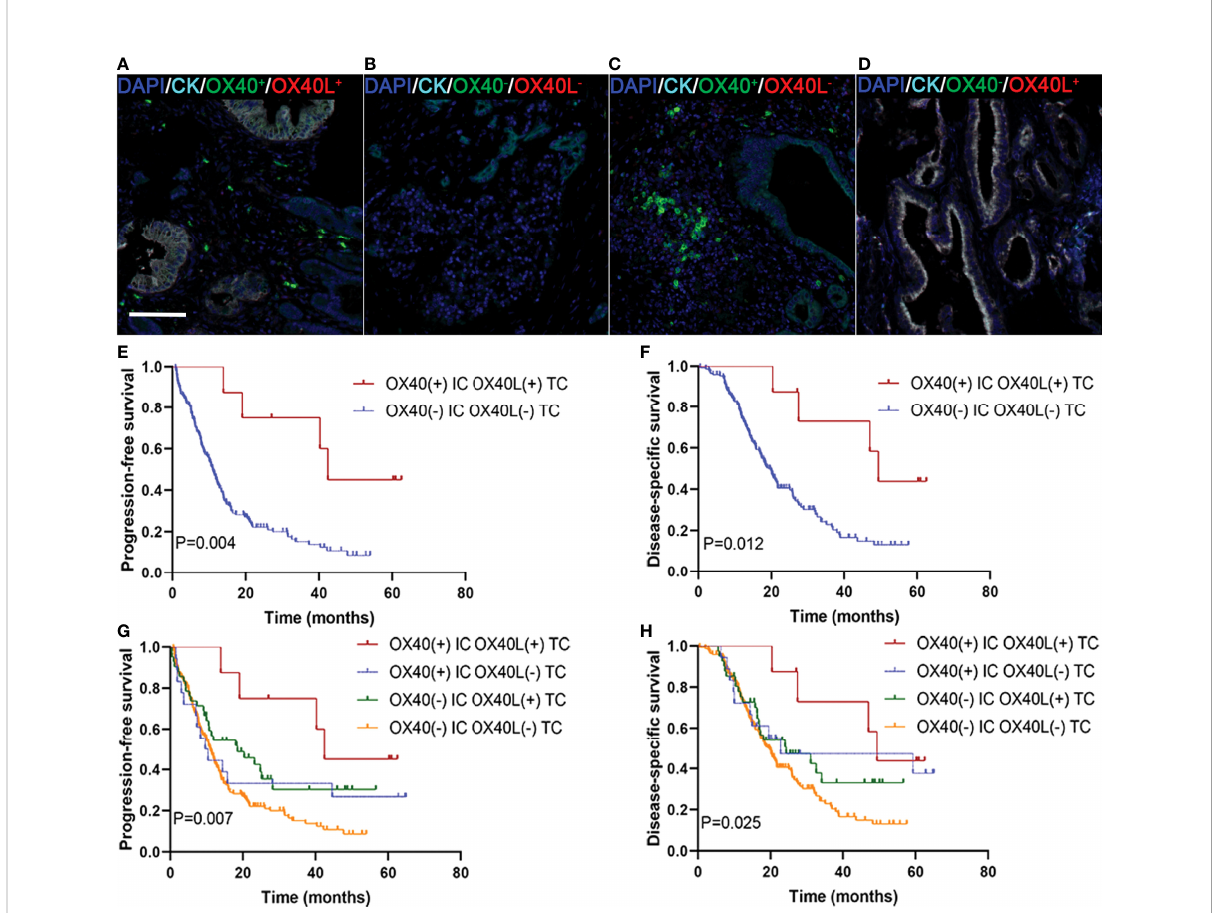
FIGURE 4 Localization of OX40 on immune cells (ICs) and OX40L on tumor cells (TCs) and their correlations with prognosis in PDAC. (A) OX40+ on ICs/ OX40L+ on TCs, (B) OX40 − on ICs/OX40L − on TCs, (C) OX40+ on ICs/OX40L − on TCs, and (D) OX40 − on ICs/OX40L+ on TCs. Kaplan – Meier curves of PFS and DSS in patients with PDAC based on the combination of OX40 on ICs and OX40L on TCs (E – H)